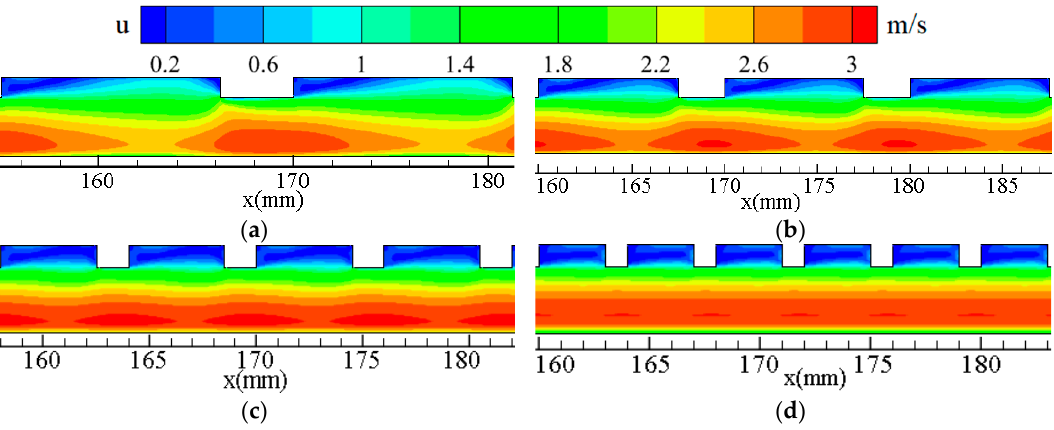
Figure 14. Contours of velocity in a narrow channel under different ( b ) L u = 10 mm; ( c ) L u = 6 mm; ( d ) L u = 4